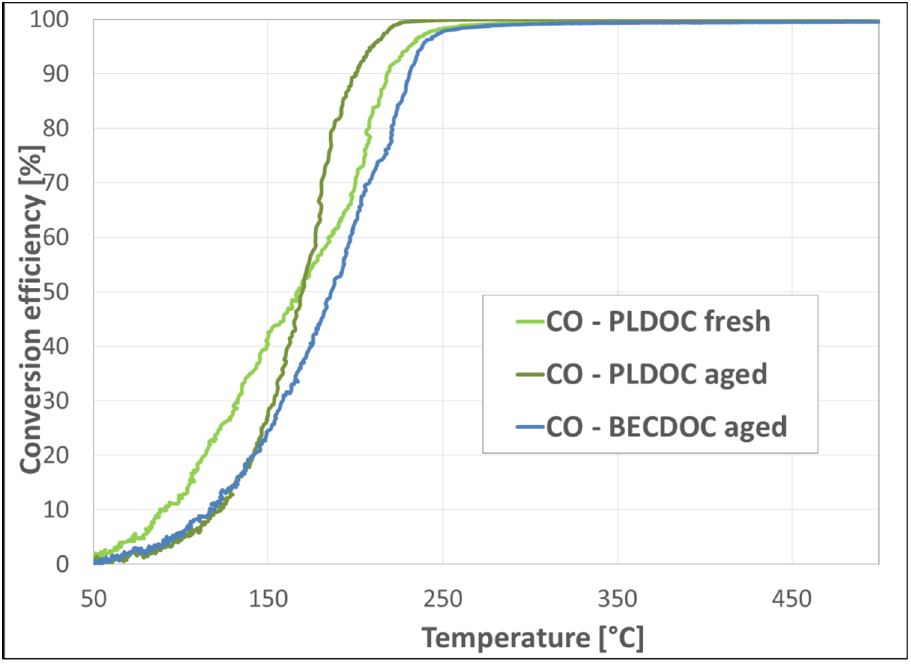
Figure 9. DOC light-off test: CO conversion efficiencies.